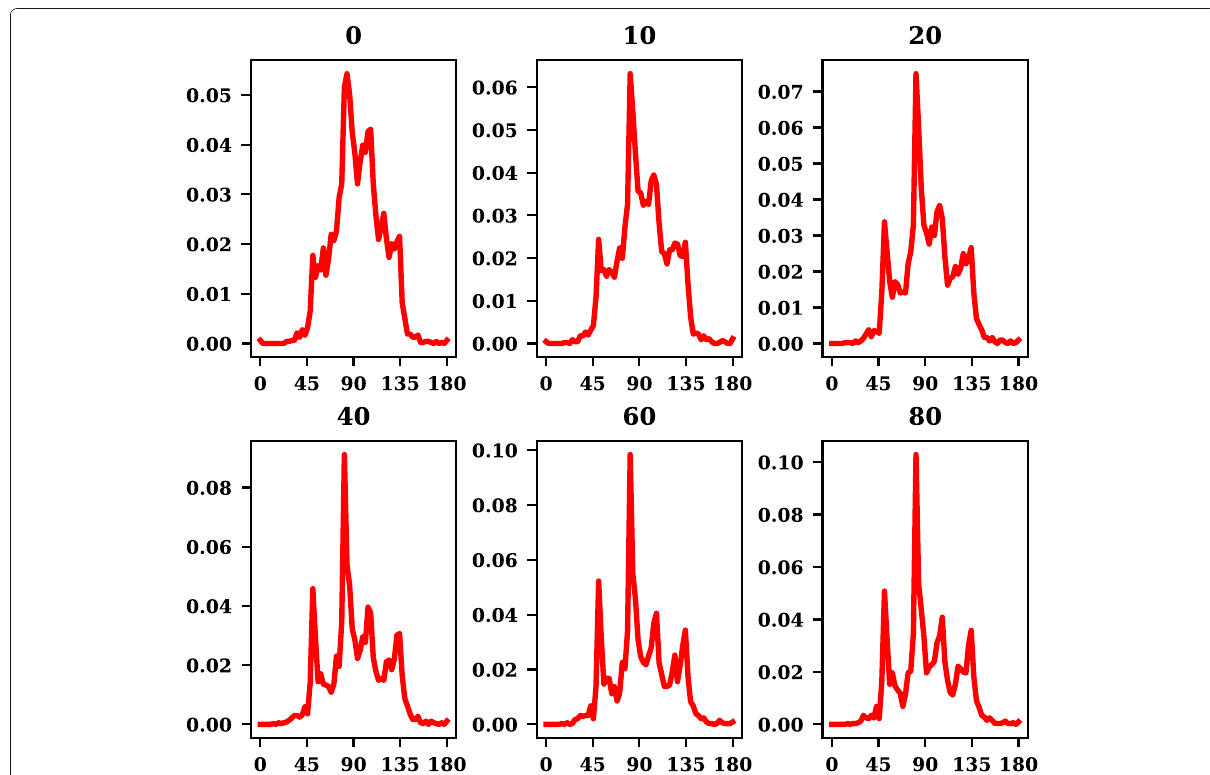
Fig. 5 Effect of β on SRP-NMF performance. Subplots show the histograms of SRP-NMF on a mixture of 4 sources taken from SiSEC database ( dev1_male4_liverec_250ms_5cm_mix.wav ) with D T = 35 and β varying from 0 to 80. β is displayed on each of the subplots. The x -axis shows DoA (degrees). The y -axis is the (normalized) frequency of